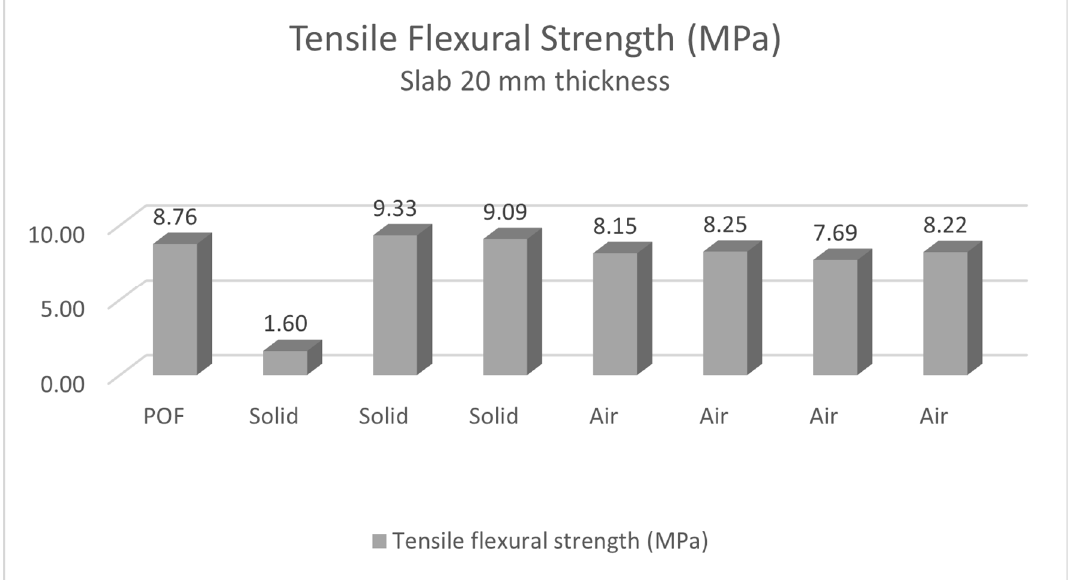
Figure 42. Tensile flexural strength of slabs of thickness 20 mm.